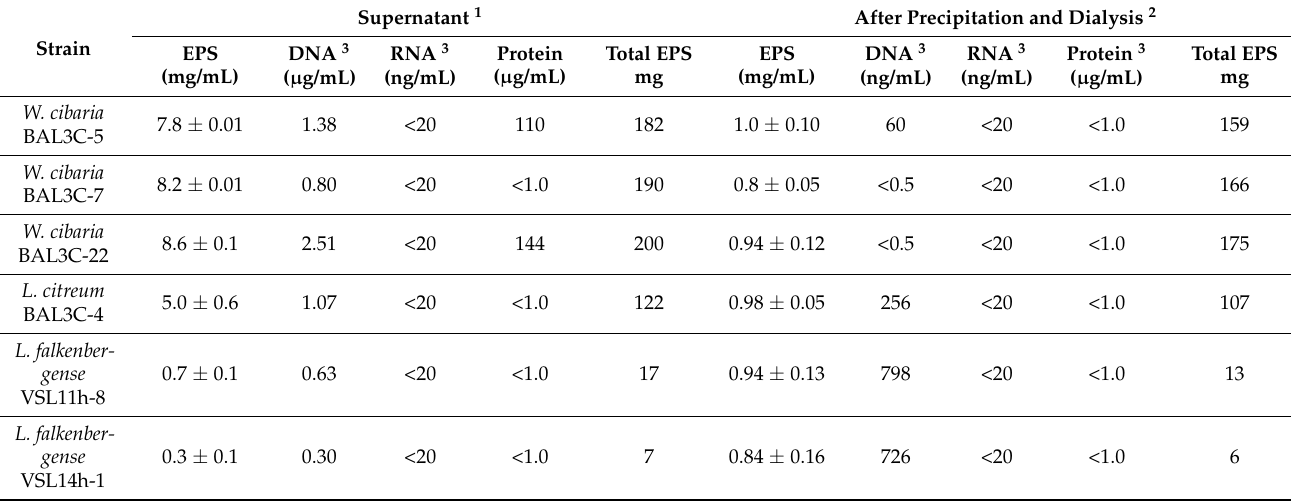
1 Protein, DNA, and RNA concentrations were measured directly from supernatants. Exopolysaccharide (EPS) concentration was determined from neutral sugars estimation after ethanol precipitation from culture supernatants. 2 Solutions of EPS were prepared in water at a concentration of 1 mg/mL. 3 The contaminants detection limits are 0.5 ng/mL for DNA, 20 ng/mL for RNA, and 1.0 µ g/mL for